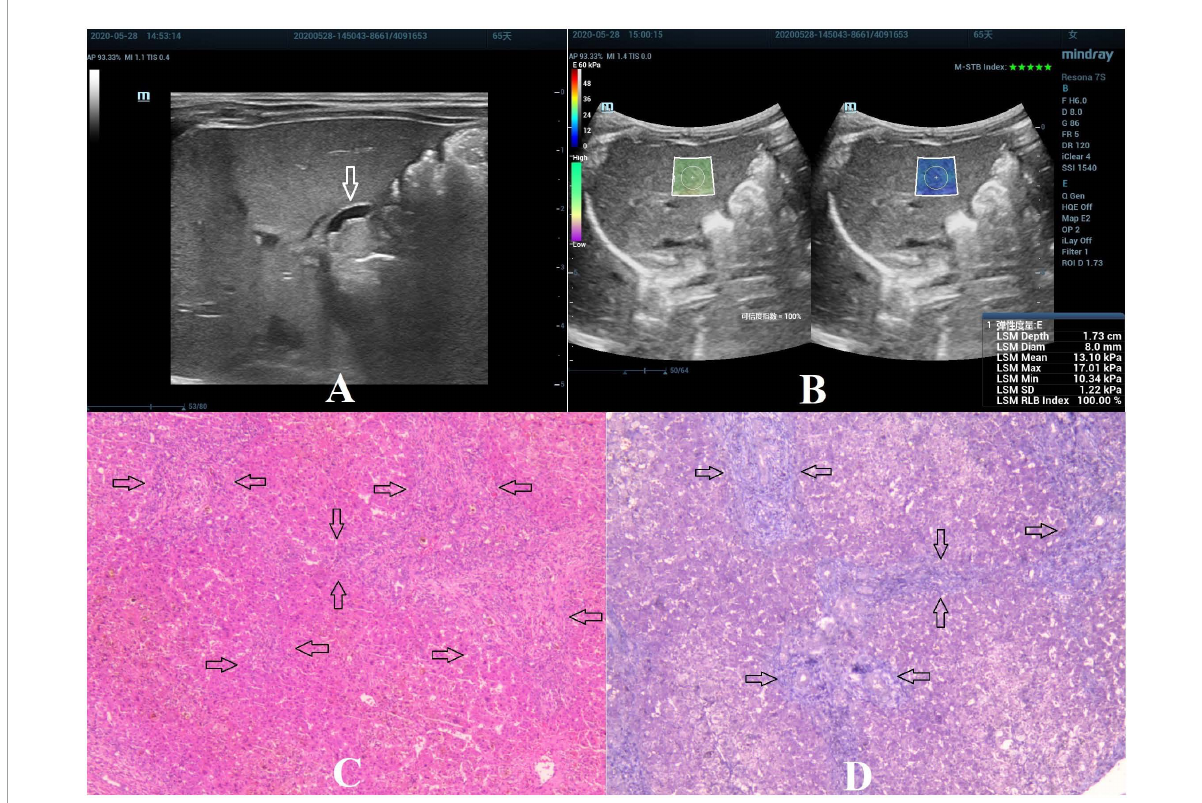
FIGURE3 Biliary atresia in a 65-day-old girl with stage F3 hepatic fibrosis. (A) Arrow indicating the gallbladder abnormality. (B) STE image showing the mean value of liver stiffness of 13.10 Kpa. (C) Hematoxylin and eosin staining (40 × magnification). The structure of the hepatic lobule was disordered, the bile canaliculi, blood vessels, and fibrous tissue proliferated in the portal area (as indicated by the arrow). (D) Masson’s trichrome staining (40 × magnification). Significant proliferation of the fibrous tissue was found, forming numerous septa, but without pseudolobule formation (as indicated by the